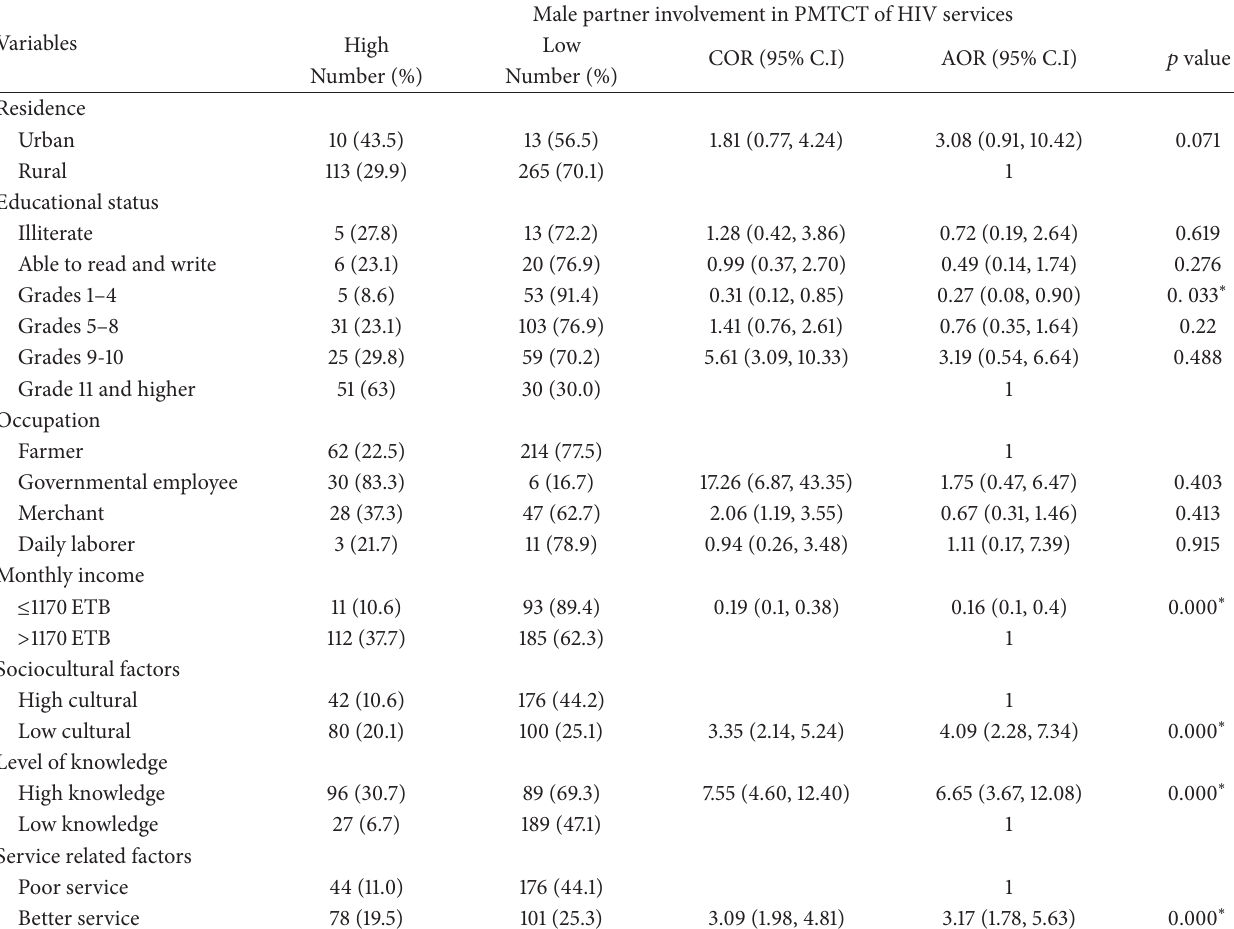
Table 2: Showing bivariate and multivariable logistic regression of factors associated with male partners’ involvement in PMTCT of HIV among males in Lemo district, Hadiya Zone, southern central Ethiopia,